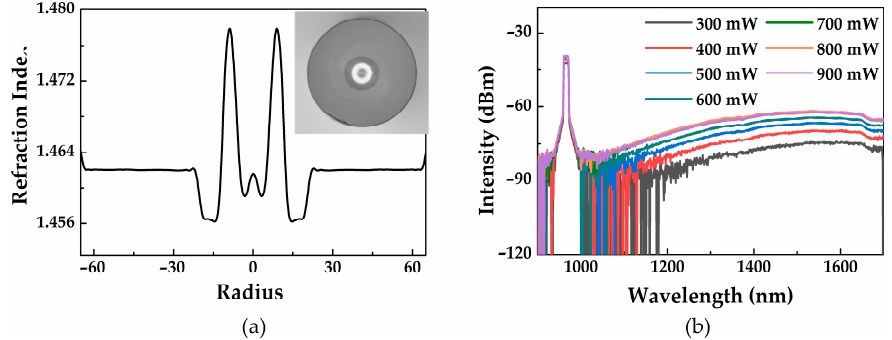
Figure 3. ( a ) Cross-section and refractive index profile curve of the PbSe-doped RCF; ( b ) Fluorescence spectrum of the fiber.